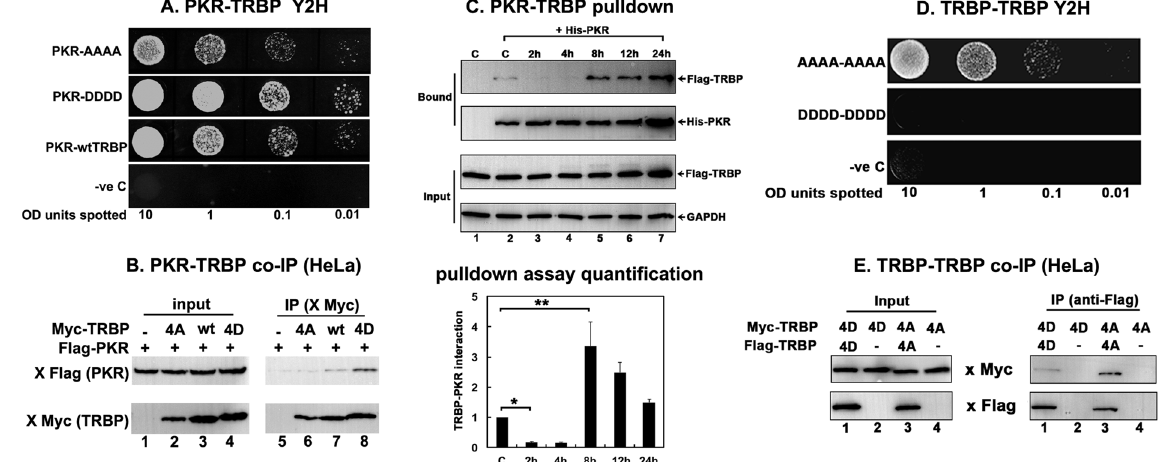
Figure 5. TRBP phosphorylation strengthens PKR-TRBP interaction and weakens TRBP-TRBP interaction. ( A ) Phospho-mimic TRBP mutant interacts stronger with PKR compared to the phospho-defective TRBP mutant in yeast two-hybrid assay. PKR/pGAD424 and either AAAA TRBP/pGBKT7, DDDD TRBP/pGBKT7, or wt TRBP/ pGBKT7 were co-transformed into AH109 yeast cells and selected on SD double dropout media (-tryptophan, - leucine). Ten microliters of transformed yeast cells (OD 600 = 10, 1, 0.1, 0.01) were spotted on SD triple dropout media (-tryptophan, - leucine, - histidine) containing 10 mM 3-amino-1,2,4-triazole (3-AT). Plates were incubated for 3 days at 30 °C. Transformation of PKR in pGAD424 and pGBKT7 empty vector served as a negative control. ( B ) Phosphomimic TRBP mutant shows stronger heteromeric interaction with PKR compared to the phosphodefective TRBP mutant in mammalian cells. HeLa cells were transfected with Flag K296R PKR/ pcDNA 3.1 − and either myc TRBP AAAA/pcDNA 3.1 − , myc wt TRBP/pcDNA 3.1 − , or myc TRBP DDDD/ pcDNA 3.1 − . The cells were harvested 24 hours after transfection, and myc AAAA, DDDD or wt TRBP was immunoprecipitated using anti-myc monoclonal antibody conjugated agarose beads. Co-immunoprecipitated Flag PKR was analyzed by western blot analysis with an anti-Flag antibody (IP: x Flag (PKR) panel). The blot was subsequently re-probed with anti-myc antibody to ensure equal myc TRBP immunoprecipitation from each sample (IP: x myc (TRBP) panel). Equal Flag PKR and myc TRBP expression in all samples was tested by western blot analysis of equal amounts of total cell lysate with anti-myc, and anti-Flag antibodies (input: x Flag (PKR) and x myc (TRBP) panels). ( C ) Changes in TRBP association with PKR. Flag TRBP overexpressing cells were treated with 25 μ M sodium arsenite for the indicated time points. Cell extracts were prepared in the presence of a phosphatase inhibitor and 25 μ g of cell extract was incubated with 500 ng of pure recombinant hexahistidine (His)-tagged PKR immobilized on Ni 2 + -agarose beads. After washing the beads, PKR-associated Flag TRBP was analyzed by SDS polyacrylamide gel electrophoresis followed by western blot analysis with anti-Flag antibody. Western blot analysis was also performed with anti-His antibody to ensure equal His- PKR in each sample. 25 μ g of cell extract was also analyzed by western blot analysis with anti-Flag and anti-GAPDH antibodies to ensure equal addition of cell lysate for each pull down (Input). Quantification of TRBP-PKR pull down: Band intensities were quantified using ImageQuant TL Software, and the ratios of bound TRBP to bound PKR across all samples were calculated and normalized to the band intensities of Flag-TRBP input for each sample. Bound TRBP/his-PKR ratios for all samples were all expressed relative to the control sample (Lane 2). Averages from three independent experiments are plotted as bar graphs ± S.D. One-way ANOVA followed by post-hoc Tukey test was performed, asterisk * p value 0.0000012 and double asterisk ** p value 0.0066374. ( D ) Phosphomimic TRBP mutant shows stronger homomeric interaction compared to the phosphodefective TRBP mutant in yeast two-hybrid assay. AAAA TRBP or DDDD TRBP point mutants in pGADT7 and pGBKT7 were co-transformed into AH109 yeast cells and selected on SD double dropout media (-tryptophan, -leucine). Ten microliters of transformed yeast cells (OD 600 = 10, 1, 0.1, 0.01) were spotted on SD triple dropout media plate (tryptophan, -leucine, -histidine) containing 10 mM 3-amino-1,2,4-triazole (3-AT). Plates were incubated for 5 days at 30 °C. Transformation of pGADT7 and pGBKT7 empty vectors served as a negative control. ( E ) Phosphomimic TRBP mutant shows stronger homomeric interaction compared to the phosphodefective TRBP mutant in mammalian cells. HeLa cells were transfected with either myc TRBP DDDD/pcDNA 3.1 − and Flag TRBP DDDD/pcDNA 3.1 − or Flag TRBP AAAA/pcDNA 3.1 − and myc TRBP AAAA/pcDNA 3.1 − . The cells were harvested 24 hours after transfection, and Flag TRBP AAAA or DDDD was immunoprecipitated using anti-Flag monoclonal antibody conjugated agarose beads. The co-immunoprecipitation of myc-TRBP was analyzed by western blot analysis with an anti-myc antibody (IP: x Myc panel). Blot was subsequently stripped and re-probed with anti- Flag antibody to ensure equal Flag-TRBP immunoprecipitation from each sample (IP: x Flag panel). Equal AAAA TRBP and DDDD TRBP expression in all samples was tested by western blot analysis of equal amounts of total cell lysate with anti-myc, and anti-Flag antibodies (Input: x Myc and x Flag